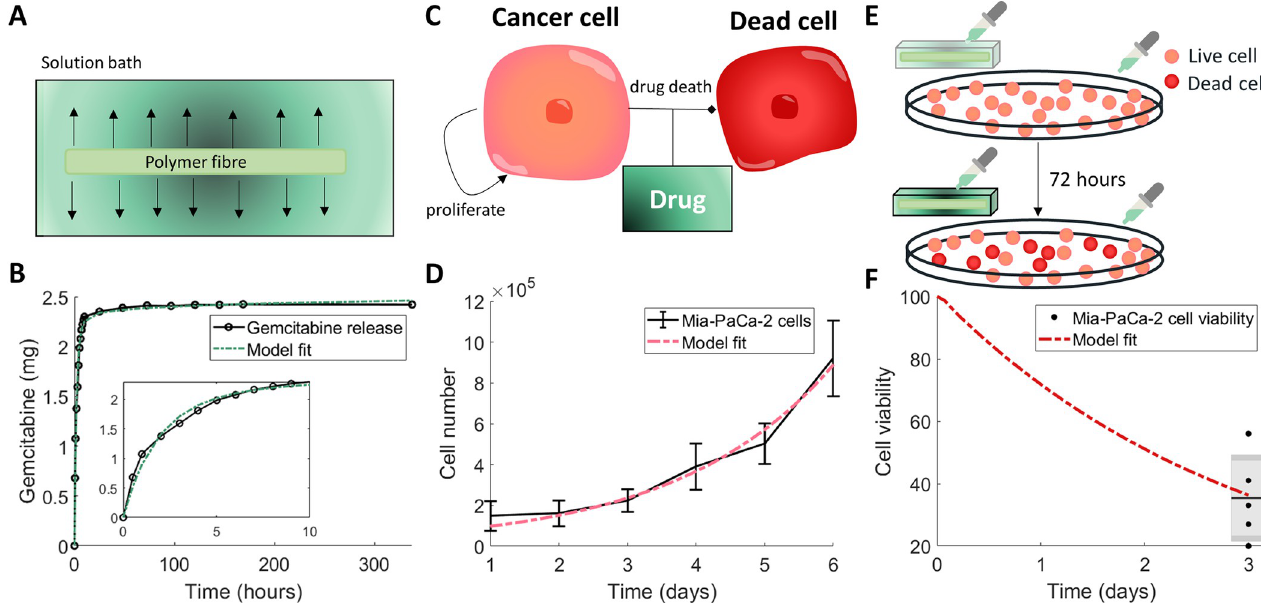
Fig 3. Calibration of model parameters to in vitro experiments. (A) Drug release profiles for gemcitabine with 3% alginate 15% PCL were measured by placing the gemcitabine–loaded alginate fibre in a solution bath and measuring the released drug concentration over time. (B) The drug concentration in the solution bath (black) was used to fit model parameters for the drug release from the fibre (green). Resulting parameters are in Table A in S1 Text . (C) The drug–induced death rate of pancreatic cancer cells was determined by simplifying the full model assumptions to consider a homogeneous model for live cancer cells P ( t ) that were proliferating and dying (become dead cells P ( t )) through the effect of the drug gemcitabine C ( t ), Eqs (9)–(11) .(D) Fitting an exponential L D growth curve to Mia–PaCa–2 cell proliferation in vitro [91] gave the growth rate of cells ϕ . Values are the mean ± std. (E) To measure the efficacy of the protocol, the cell viability was determined after aliquots from drug released from gemcitabine–loaded fibre were placed in a well with proliferating Mia–PaCa–2 cells at 24, 48 and 72 hours. (F) The resulting cell viability at 72 hours from the experiment depicted in (E) was used to fit the drug–induced cell death rate ( Eqs (9)–(11) ).The data is plotted as a box and whisker plot. Resulting parameters for (D) and (F) are in Table B in S1 Text